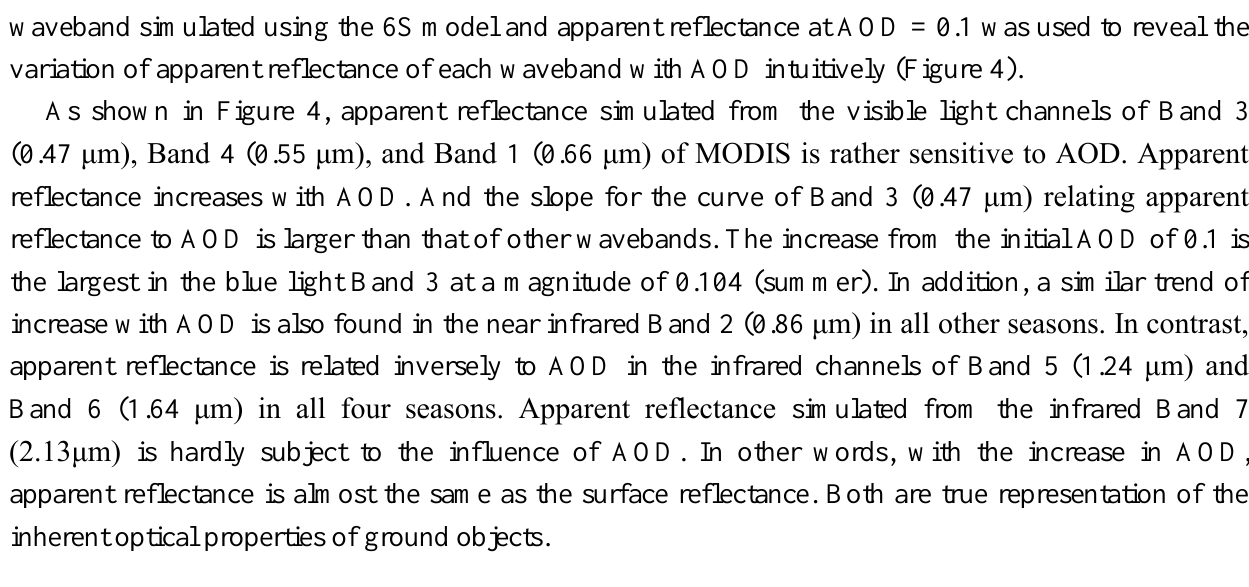
Figure 4. Relationship between apparent reflectance simulated using the 6S model